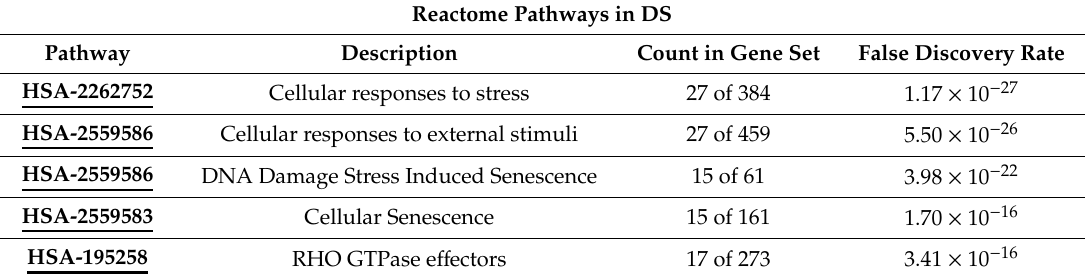
Table 4. Highlights of the 5 most significant reactome pathways involving proteins overexpressed in the DS